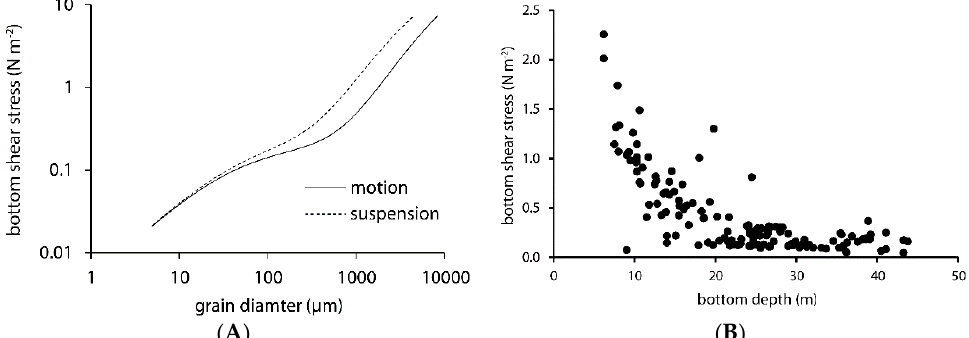
Figure 1 . ( A ) Dimensional Shields Curve for spherical quartz grains (density: 2.65 g cm -3 ) sheared by seawater (salinity: 33 PSU, temperature: 10 °C). The solid curve indicates the critical bottom shear stress for the initiation of motion [14]; the dashed curve indicates the threshold for suspension [15]. ( B ) Annual average of the total bed shear stress due to wave orbitals and the residual current at the sampled locations, as estimated by the TRIM ( T idal, R esidual, I ntertidal M udflat) model (coastMap).